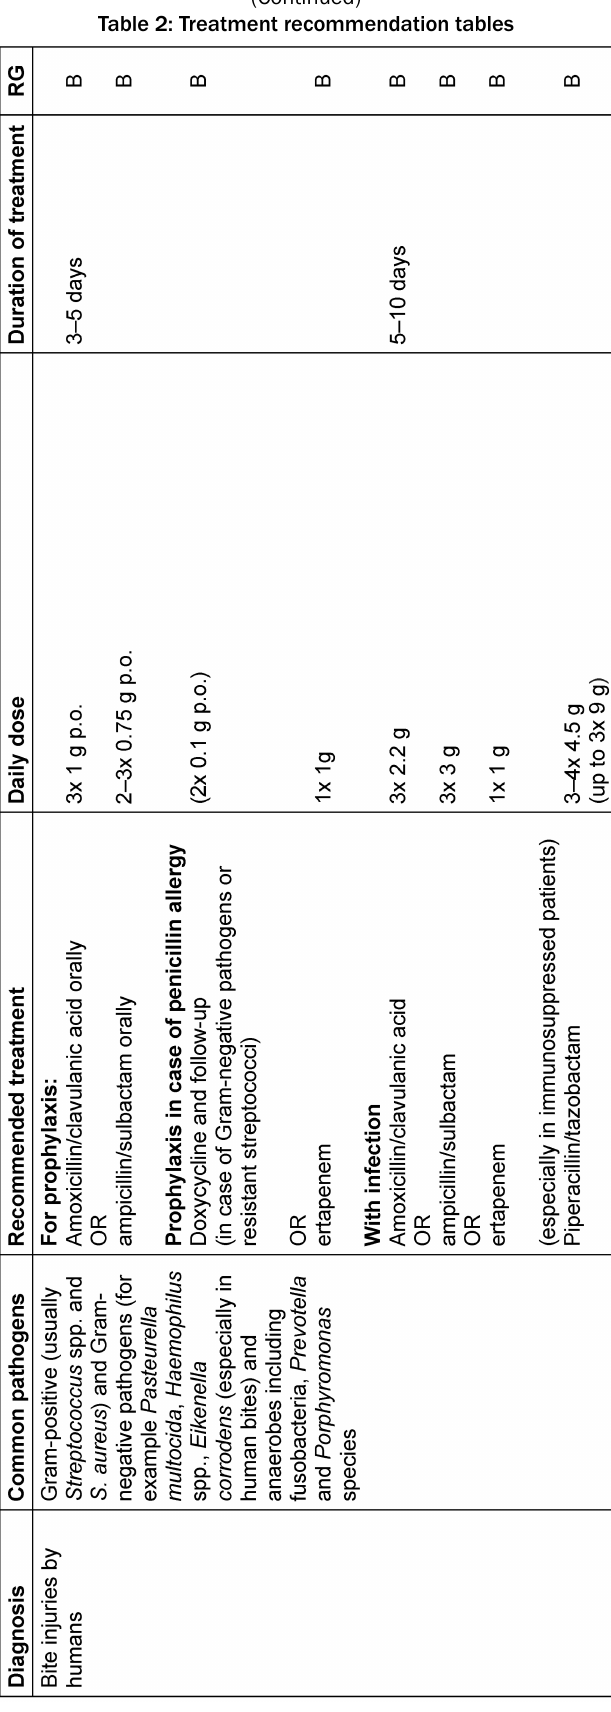
Table 2: Treatment recommendation